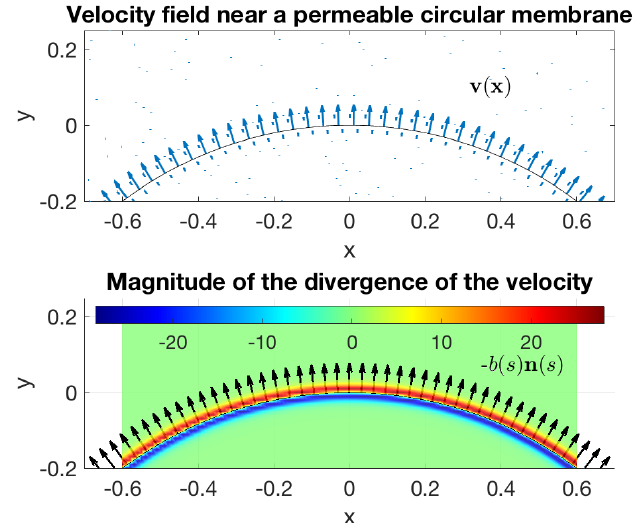
Figure 1. General setting of the problems considered in this article. The figure shows a section of a circular permeable membrane. The top panel shows a neighborhood of the membrane and the velocity field across the membrane from the inside to the outside. This flow is generated by a distribution of source doublets on the membrane, − b ( s )( ˆn ( s ) · ∇ ) ∇ G δ with b ( s ) < 0 and ˆn is the outward unit normal. The bottom panel shows the vectors − b ( s ) ˆn ( s ) (black arrows) and the divergence of the velocity